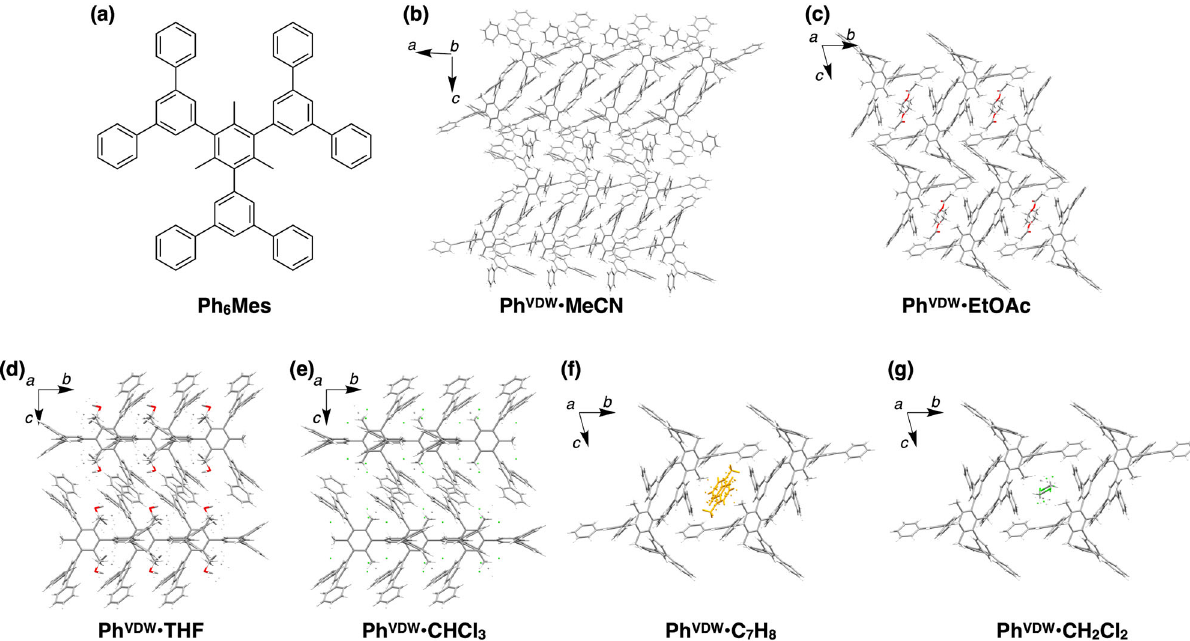
Fig. 5 Crystal packing diagrams of the polymorphs of Ph 6 Mes. a Molecular structure of Ph 6 Mes . b – g Crystal packing diagrams of Ph VDW ·MeCN ( b ), Ph VDW ·EtOAc ( c ), Ph VDW ·THF ( d ), Ph VDW ·CHCl 3 ( e ), Ph VDW ·C 7 H 8 ( f ), and Ph VDW ·CH 2 Cl 2 ( g ). The guest toluene molecules are colored in orange for clarity. Table 2 Crystallographic information of the polymorphs of m -Py 6 Mes. Crystallization solvent